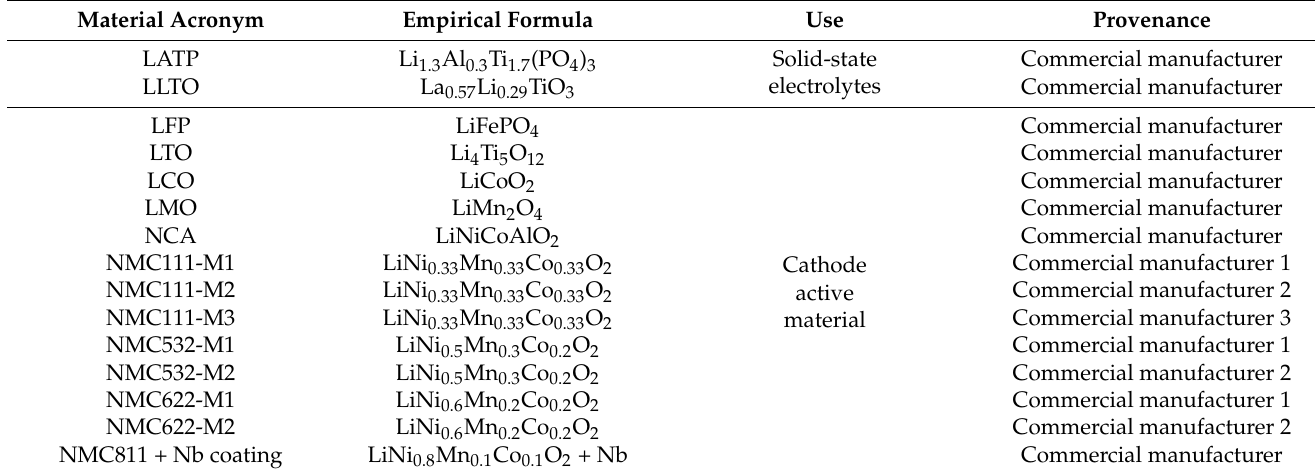
Table 1. Summary of the analyzed battery material samples.